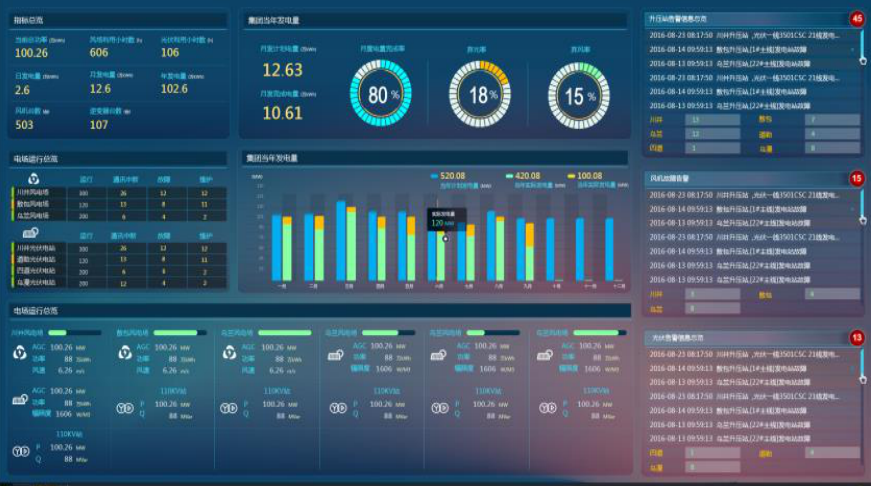
Figure 6. Monitoring platform in operating status.